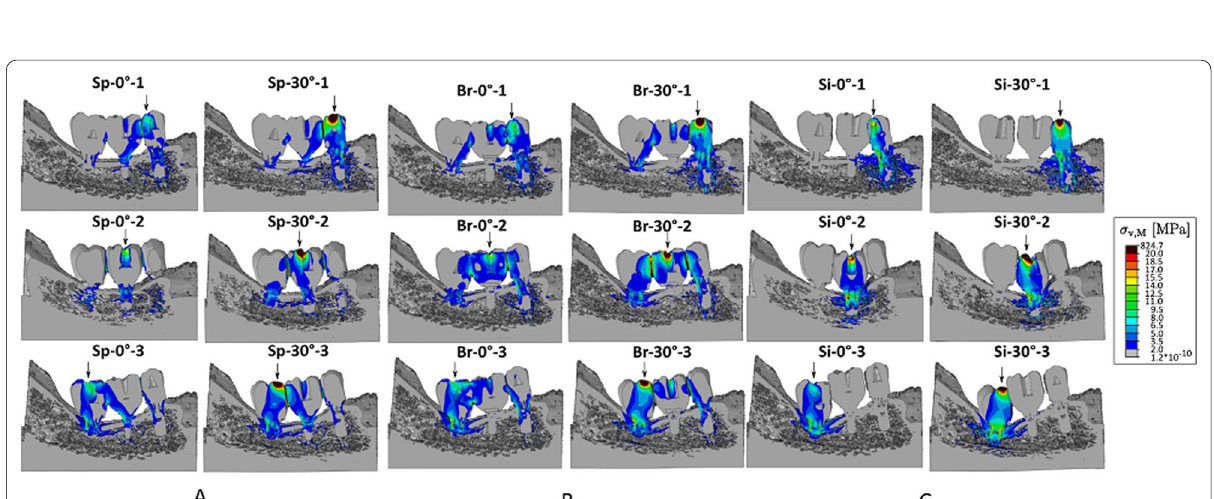
Fig. 5 von Mises stress distribution for every load case of tested configurations. A Splinted crowns configurations. B Bridge configurations. C Single crowns configurations. Deformation scale factor: 600 . The yield stress limit of the bone is equivalent to stresses above 20 MPa (dark red) (100 N × applied instead of physiological value of 500 N, rescale